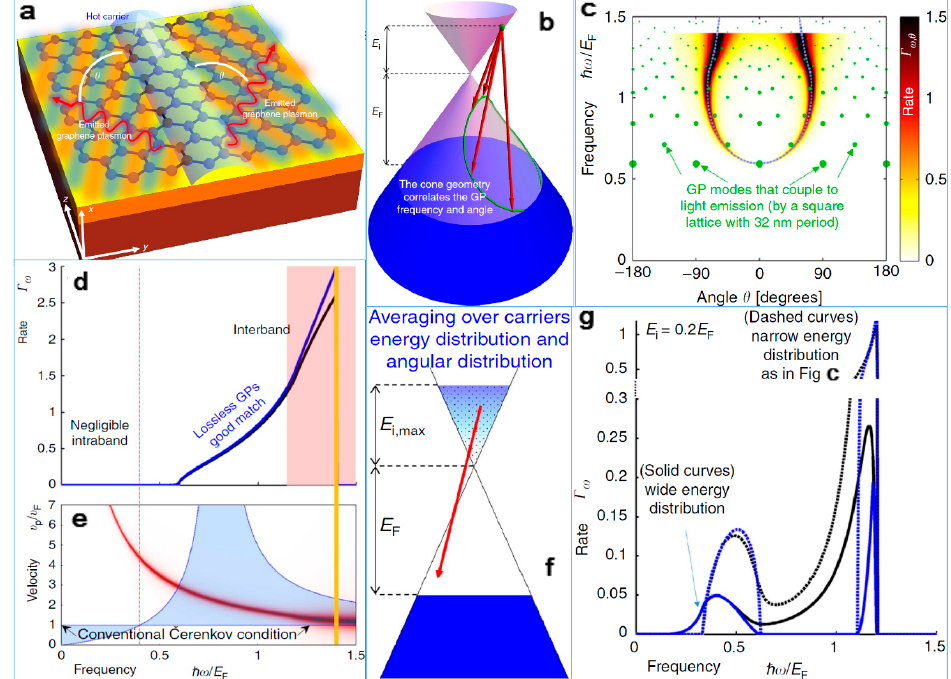
Figure 3. ( a ) Illustration of the plasmon emission from charge carriers in graphene via a 2D Č erenkov process. ( b ) Illustration of the possible transitions. The hot carrier (green dot) has a range of potential transitions (red arrows) with distinct final states (green curves and circles), emitting plasmons that satisfy conservation of momentum and energy (corresponding to the height and angle of the red arrows). In this way, the cone geometry correlates the graphene surface plasmon (GSP) frequency and angle. The projection of these arrows to a 2D plane predicts the in-plane angle y of the plasmonic emission, matching the ( c ) map of GSP emission rate as a function of frequency and angle. ( d ) Spectrum of the Č E ( Č erenkov effects) GSP emission process of radiation rate. ( e ) Explaining the GSP emission with the quantum Č E. The GSP phase velocity is plotted as a red curve, with its thickness